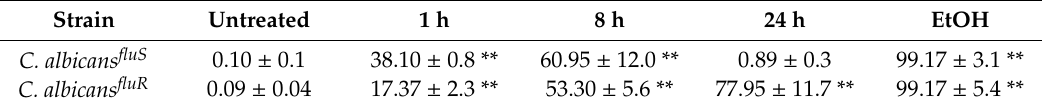
Table 3. PI-positive C. albicans cells at 1 h, 8 h and 24 h of PAFC treatment evaluated by FACS analysis § . Strain Untreated 1 h 8 h 24 h EtOH C. albicans